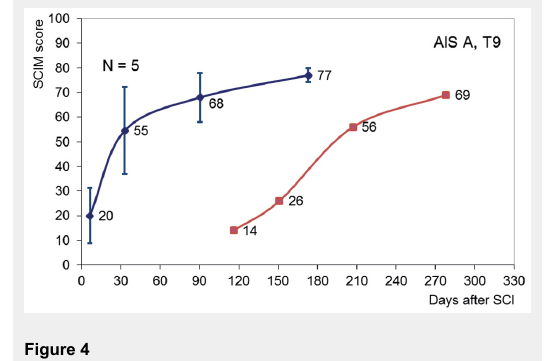
Delayed onset of rehabilitation. Improvement in Spinal Cord Independence Measure (SCIM) scores from a patient with a sensory motor complete (AIS A) lesion at thoracic 9 (T9), who entered rehabilitation with an almost 4 month delay in onset (red line). Averaged improvements in SCIM score (with SD) of 5 patients matched for severity and level of lesion (blue line). The results indicate that without rehabilitation, spontaneous improvement in activities of daily life is